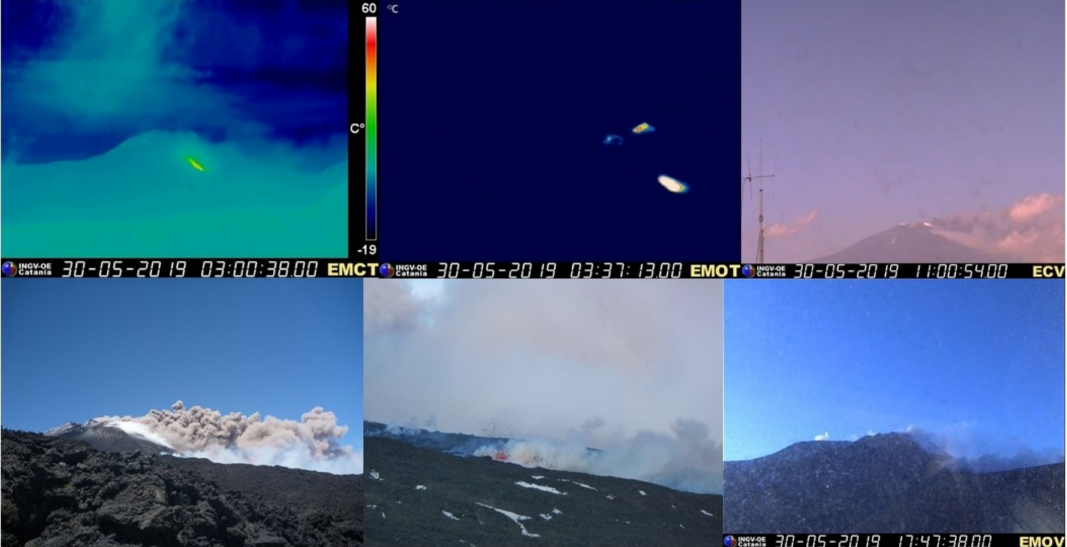
Figure 1. Etna activity on 30 May 2019 as seen from Istituto Nazionale di Geofisica e Vulcanologia, Osservatorio Etneo (INGV-OE) video-surveillance systems showing the lava flow formation at the east and south-east flank of the New Southeast Crater (NSEC) from EMCT (Etna Monte Cagliato Thermal) and EMOT (Etna MOntagnola Thermal) cameras, explosive activity between 3500 and 4000 m a.s.l. during monitoring activities of INGV-OE (photo of Simona Scollo). The EMOV camera shows the decrease of the explosive activity after about 17:30